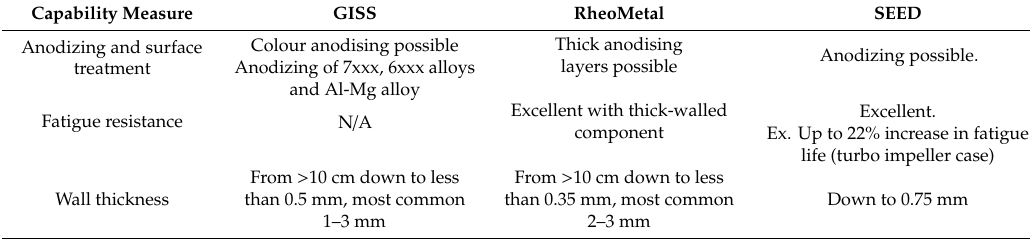
Table 2. Collation of process capabilities